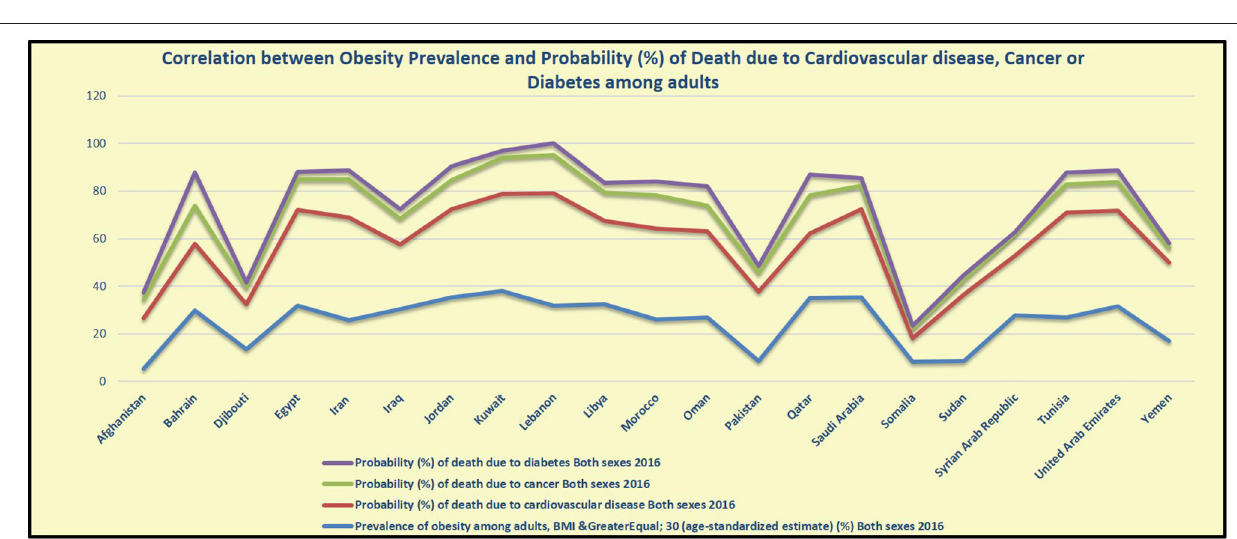
FIGURE 5 | Correlation between the prevalence of obesity, probability of death due to CVDs, cancers, and diabetes among adults in EMR